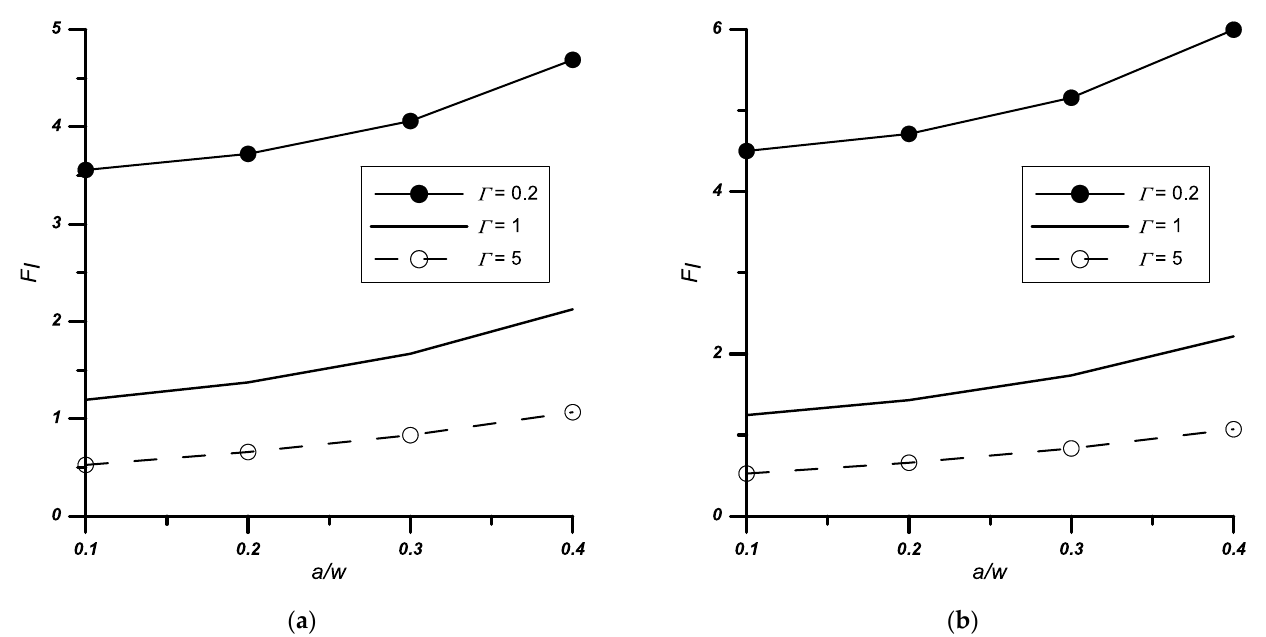
Figure 6. Variation of the normalised stress intensity factors F I with the relative stiffness Γ and notch height a / w , ( a ) notched bi-material with apex angle 2 ψ = 30°, ( b ) notched bi-material with apex angle 2 ψ = 60°.